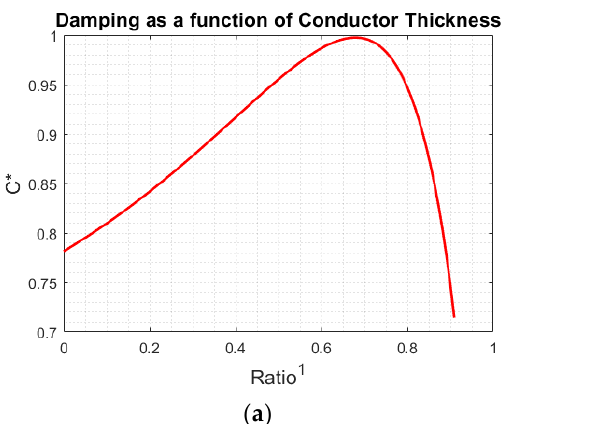
Figure 10. Conductor and back iron thickness effects: ( a ) Normalized damping coefficient vs. nor- malized conductor thickness (Ratio 1 ); ( b ) normalized damping coefficient vs. normalized back iron thickness (Ratio 2 ). The colored region cannot be used due to structural